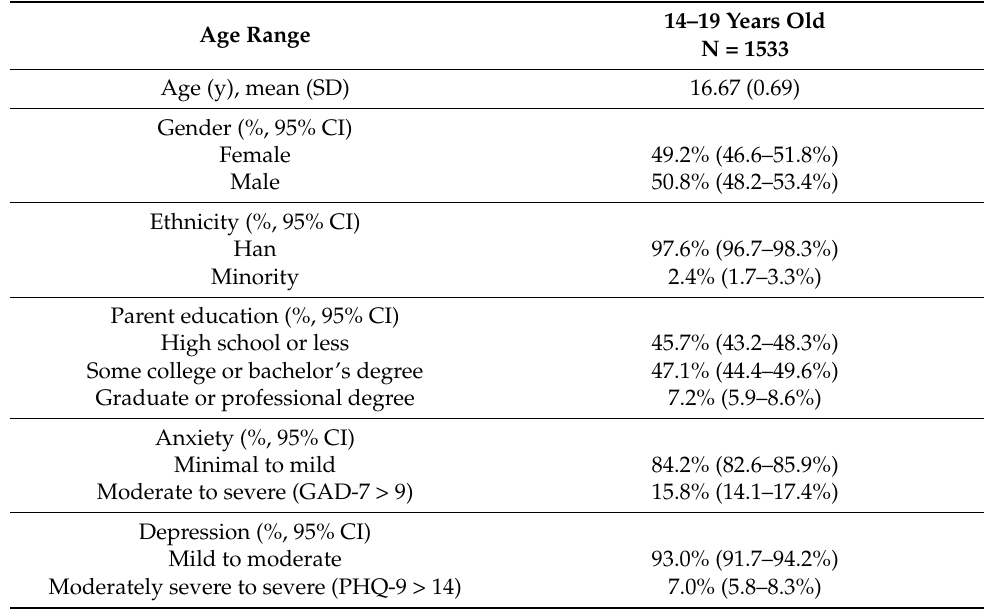
Table 1. Demographic characteristics of adolescents in high school.